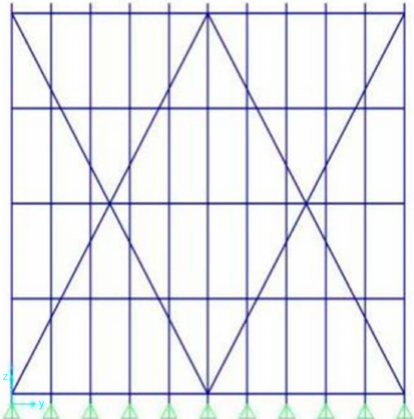
Figure 7. Finite element model of fastener steel tube formwork bracket: YZ plane.